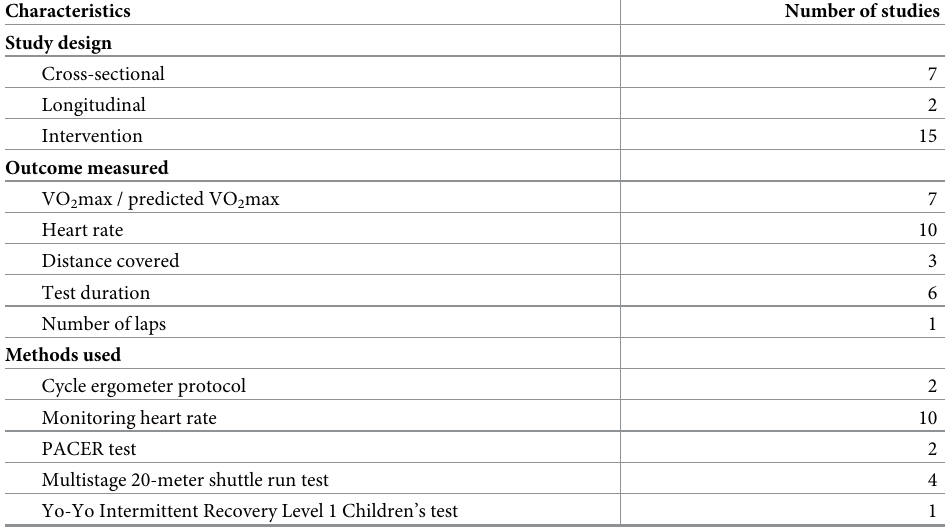
Table 2. Characteristics of the included